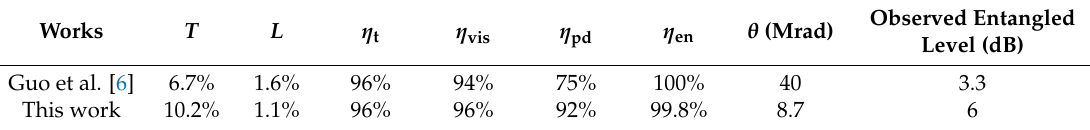
Table 1. Comparison of experimental parameters between the two